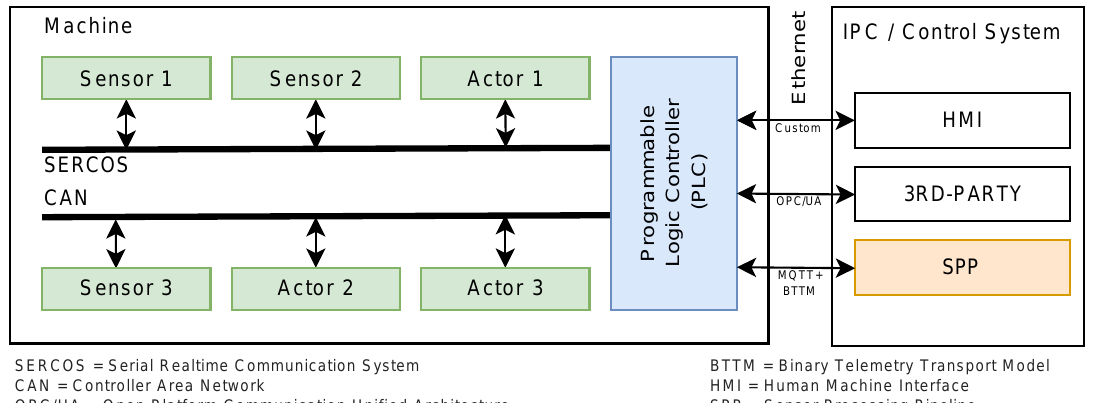
Figure 3. Communication